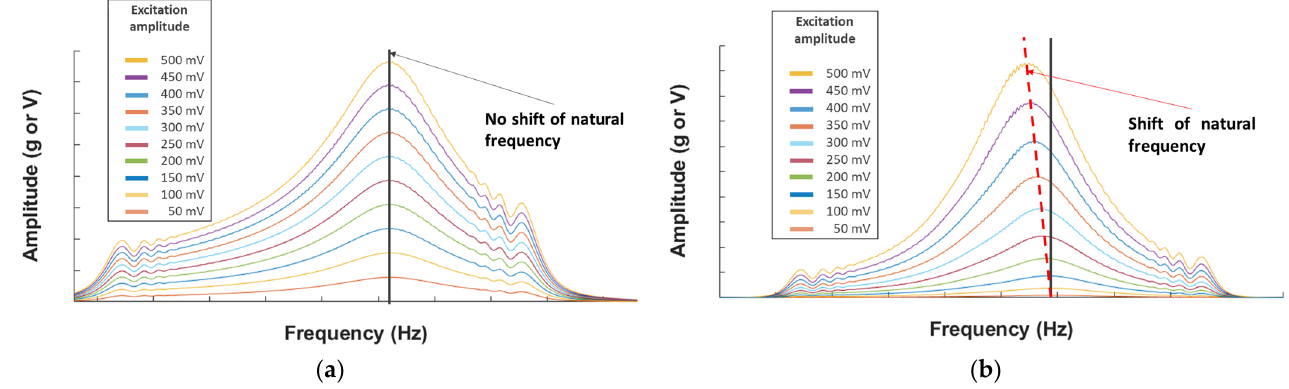
Figure 7. ( a ) Example of the NLR method for a healthy structure and ( b ) for a damaged structure.